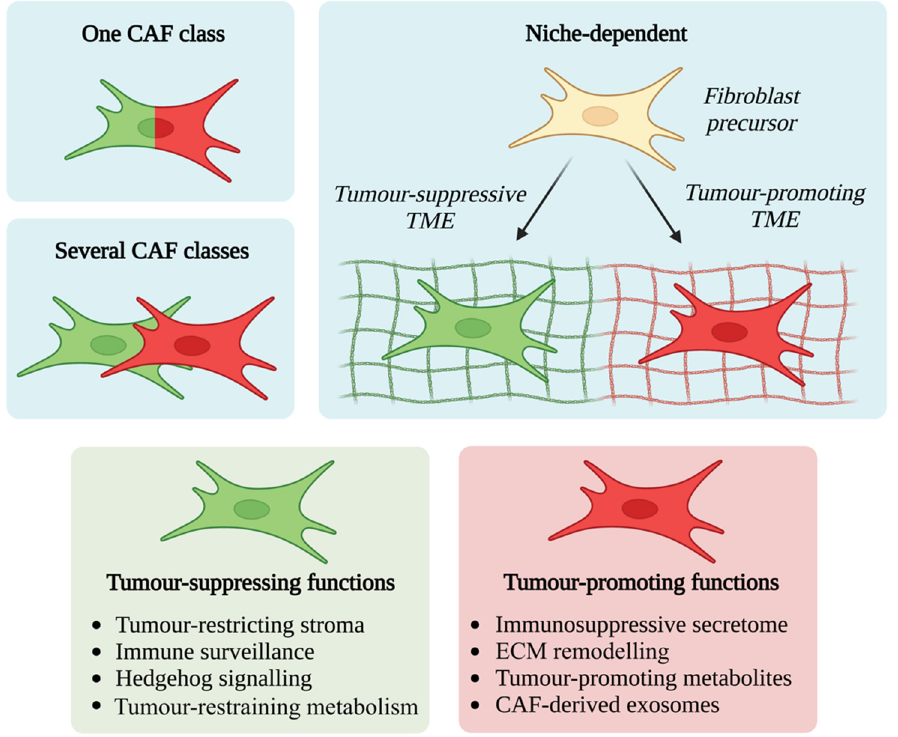
Figure 2. CAF activating factors and plasticity. Numerous mechanisms have been described to ex ‐ plain the functional heterogeneity of CAFs, including (1) a single class of CAF with multiple func